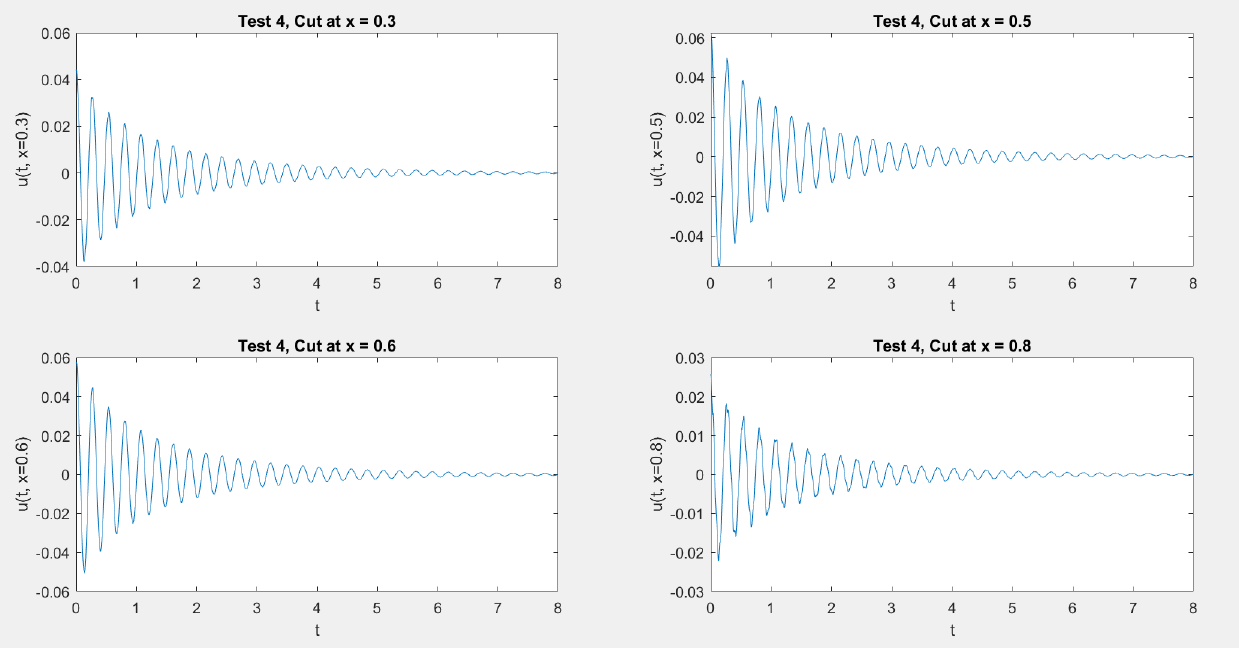
Figure 4. Test4: The solution u ( t ) at fixed values of x